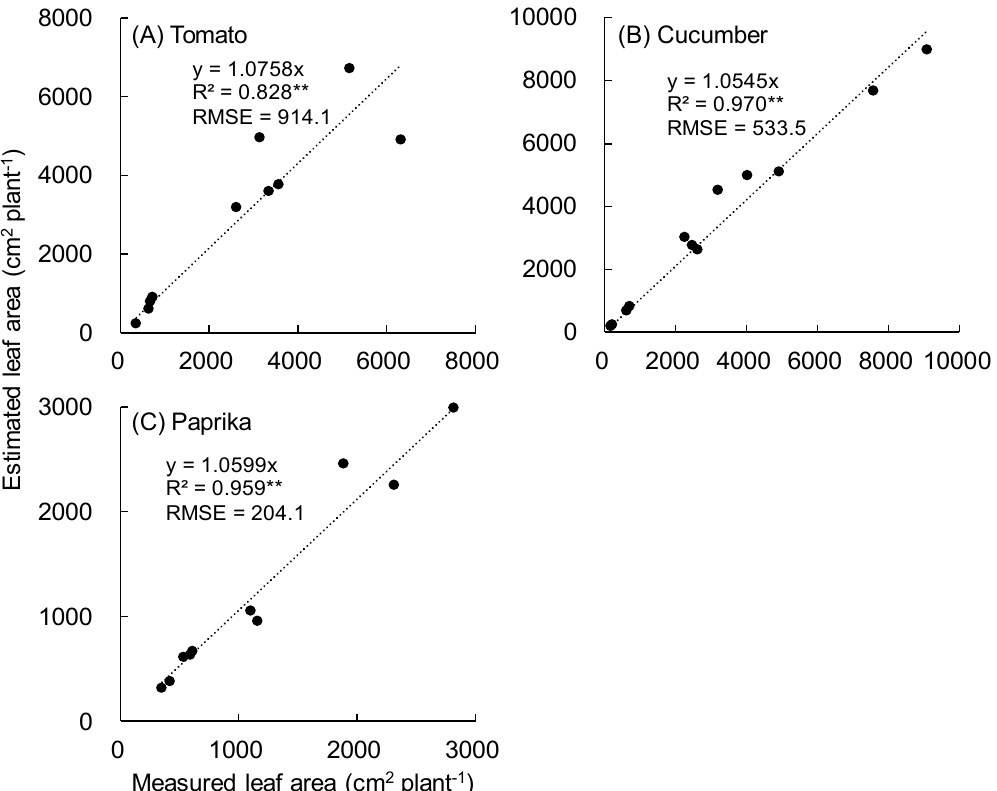
Figure 7. Relationship between measured and estimated leaf area per plant. The leaf area was measured using an area meter (LI-3100, LI-COR Inc., Lincoln, NE, USA). The leaf area was estimated based on the area of polygons in the plant surface model. Tomato plants were scanned using a 3D scanner (DPI-8X, Opt Technologies Co., Ltd., Tokyo, Japan) from 5 April to 23 May 2019 ( A ). Cucumber plants were scanned from 3 April to 23 May 2019 ( B ). Paprika plants were scanned from 5 April to 2 August 2019 ( C ). ** significant at p < 0.01 according to the regression analysis. RMSE means root mean squared error.